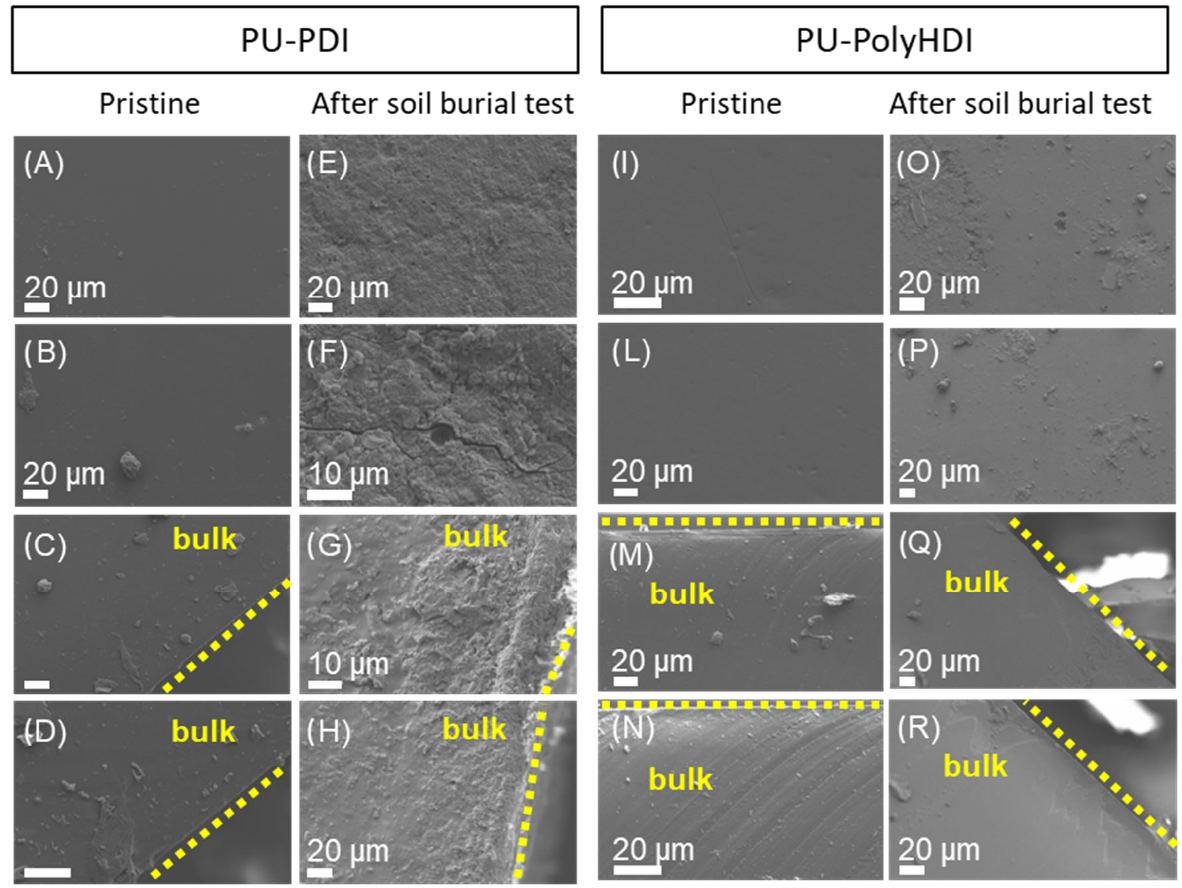
Figure 9. SEM images of samples PU ‐ PDI and PU ‐ PolyHDI. ( A , B ) and ( C , D ) surface and section (as described in Figure 6A of PU ‐ PDI, and ( E , F ) and ( G , H ) surface and section of PU ‐ PDI after soil burial test, respectively. ( I , L ) and ( M , N ) surface and section of PU ‐ PolyHDII, and ( O , P ) and ( Q , R ) surface and section of PU ‐ PolyHDI after soil burial test, respectively. In ( C , D , G , H , M , N , Q , R ) the position of the surface is indicated with yellow dashed lines.